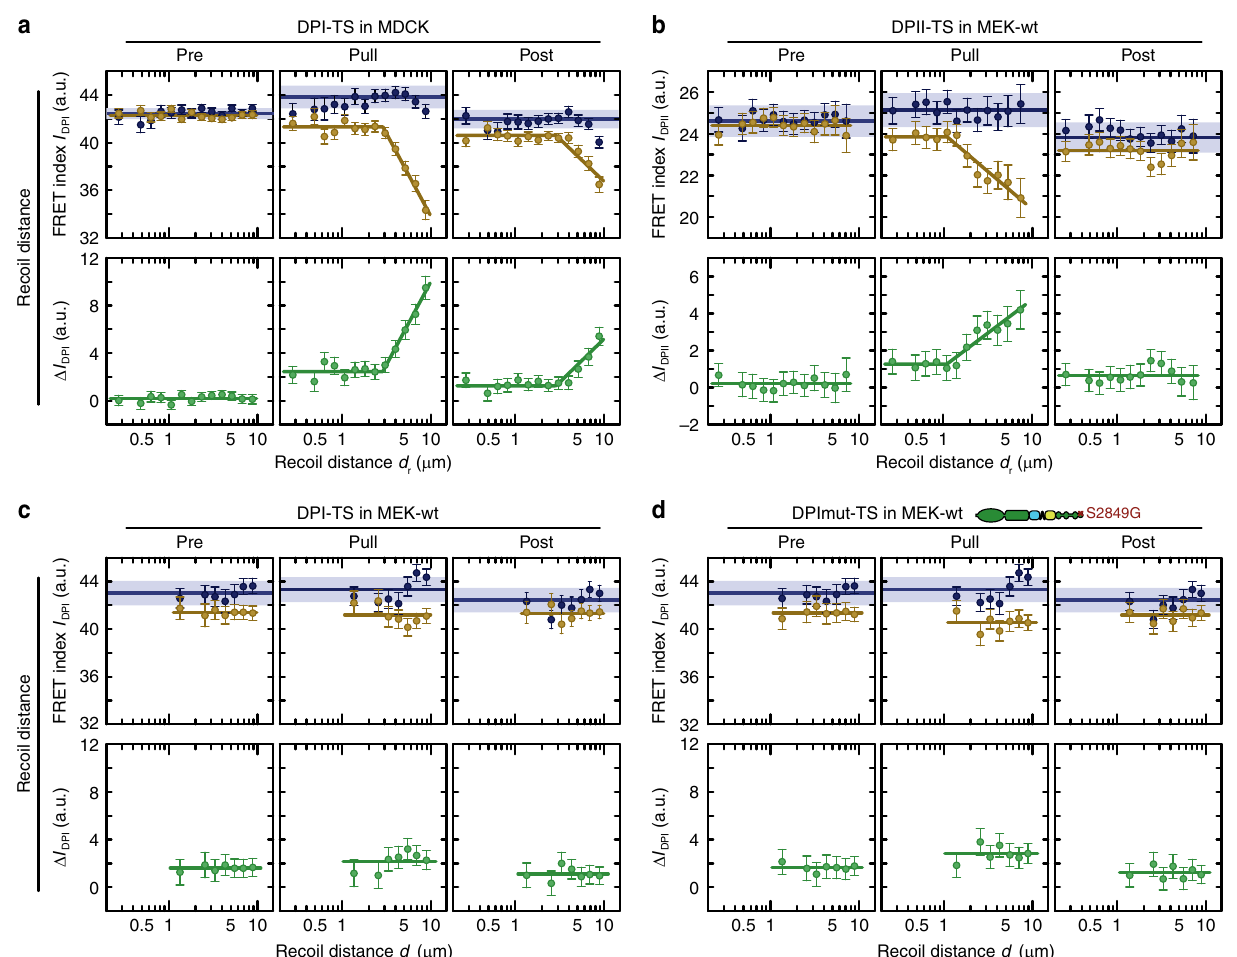
Fig. 4 DP loading is sensitive to the magnitude of the applied deformation. a Before pulling (Pre), the FRET index difference (green) between DPI-TS (yellow) and DPI-ctrl (blue) in MDCK was close to zero, con fi rming that no tension was transmitted across DPI without external stress. During pulling (Pull), tension increased with deformation. After pipette tip withdrawal (Post), tension partially relaxed. Evidence of residual tension was observed at higher recoil distances. Data are from the pulling experiment represented in Fig. 3d. b Mechanical tension on DPII depends on the degree of deformation, and relaxes after external stress is released. Data are from the pulling experiment represented in Fig. 3e. c FRET index change for DPI-TS in MEKs was small in magnitude, even at high recoil distances. P > 1450 total puncta from n ≥ 36 images measured in six independent experiments. d Introduction of the S2849G mutation in DPI-TS does not alter sensitivity to recoil distance in MEKs. P > 1250 total puncta from n ≥ 35 images measured in six independent experiments. DPI-ctrl data were the same as in c . a – d Puncta with recoil distances d r ≤ 10 μ m were analyzed. The mean FRET index of DP-TS and DP-ctrl as well as the mean difference between DP-TS and the mean of all DP-ctrl puncta were calculated using the lmer-test and displayed with the 68% CI. Blue lines and corresponding shading indicate the mean with 95% CI of all DP-ctrl puncta. Yellow and green lines are guides to the eye. Source data